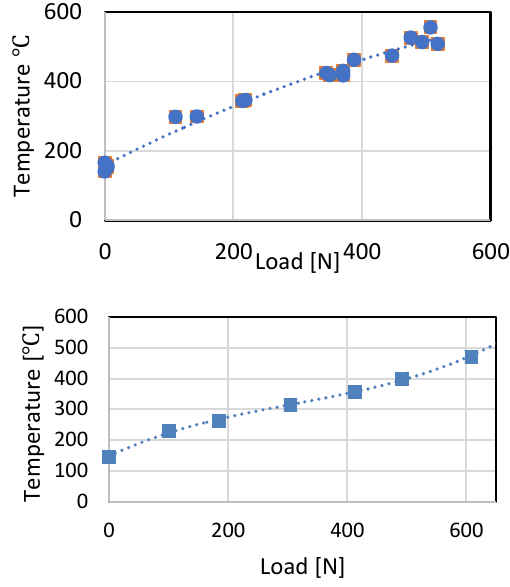
Fig. 13. Exhaust gases temperature as a function of engine load during operation in 1500 rpm and 1700 rpm